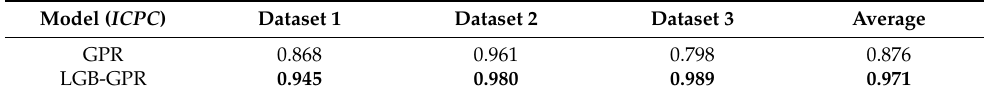
Table 5. ICPC score results statistics table.